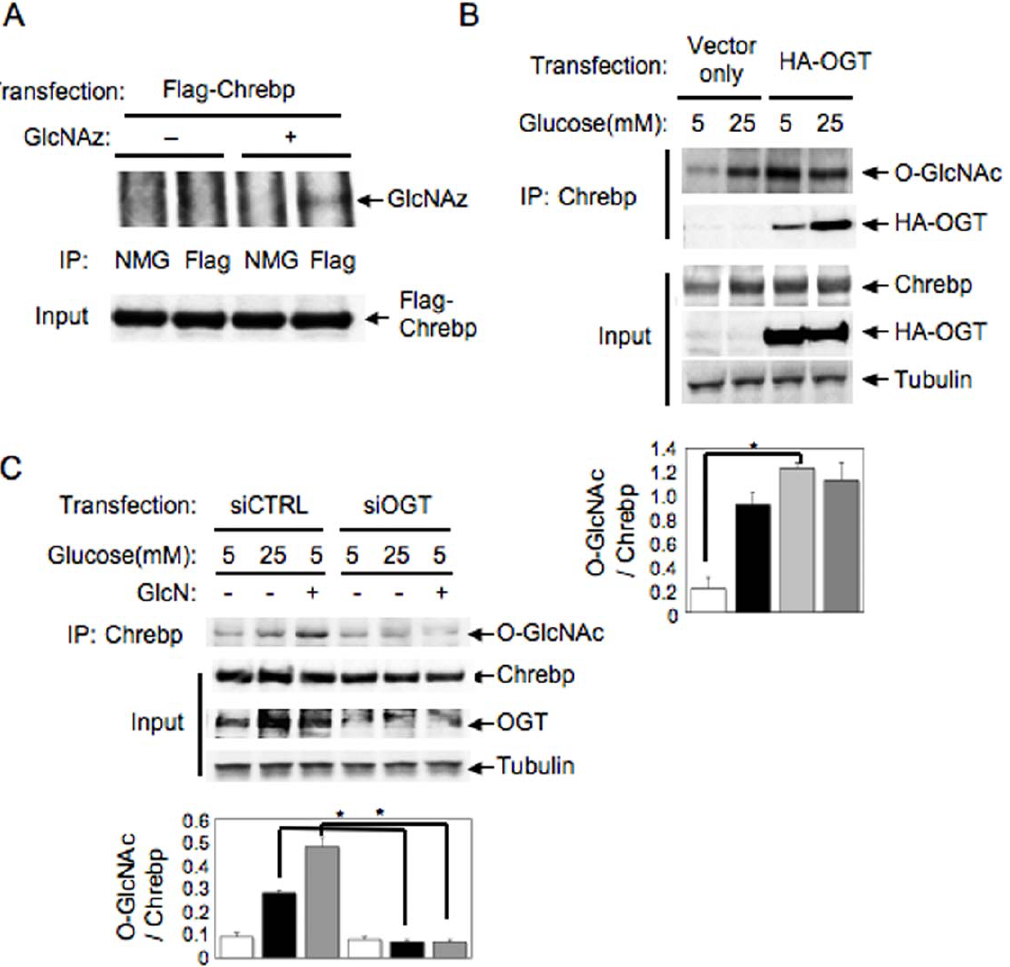
Figure 2. Chrebp O-glycosylation is regulated by OGT. (A) Mouse primary hepatocytes were transfected with Flag-Chrebp and labeled with tetraacetylated azide-modified N-acetylglucosamine (GlcNAz). The cell lysates were immunopricipitated with anti-Flag antibody or normal mouse globlin (NMG) and subjected to detection of O-glycosylation by biothin-avidin system as described in Materials and Methods. Input indicates the expression level of Flag-Chrebp in each lane. (B and C) Mouse primary hepatocytes were transfected with HA-OGT (B) or siRNA for OGT (C) along with empty vector or control siRNA, respectively and cultured with 5 mM or 25 mM glucose for 24 hr. In some experiments, 10 mM glucosamine (GlcN) was added in the medium. The cell lysates were immunoprecipitated with anti-Chrebp antibody followed by blotting with anti-O-GlcNAc or anti-HA antibody. Input indicates the expression level of Chrebp, HA-OGT, endogenous OGT or tubulin. Quantitative analyses were performed by assessment of O-glycosylation level compared with the protein level of Chrebp using densitometry, showing as a bar graph below the results of blotting (B and C). Experiments were repeated at least three times. Data represent mean 6 SEM. *P , 0.05.